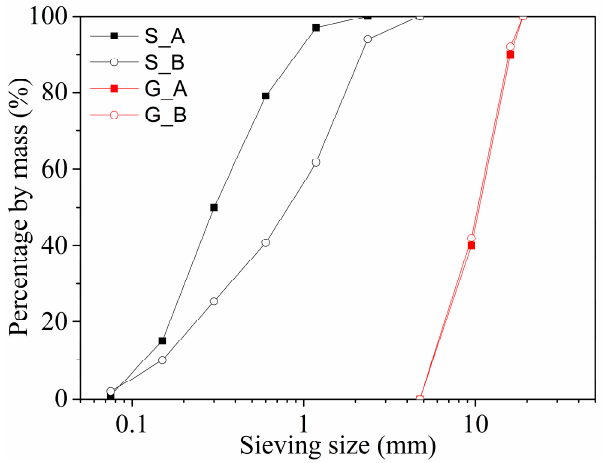
Figure 4. Particle size distribution curves of aggregates.